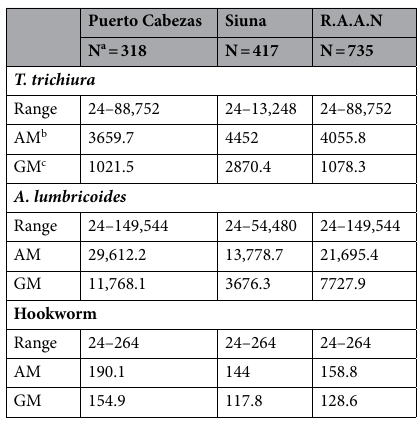
Table 3. STH infection intensity (eggs per gram of feces) obtained in the two municipalities studied and in the total R.A.A.N. (Nicaragua). a Number of schoolchildren studied. b Arithmetic mean of eggs per gram of feces. c Geometric mean of eggs per gram of